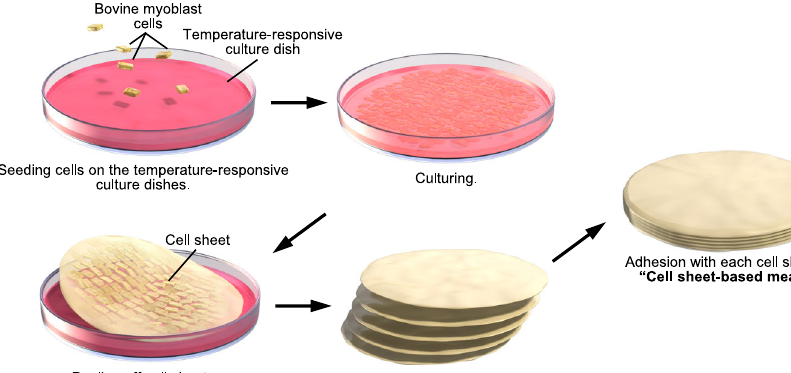
Fig. 1 Production of cell sheet-based meat.